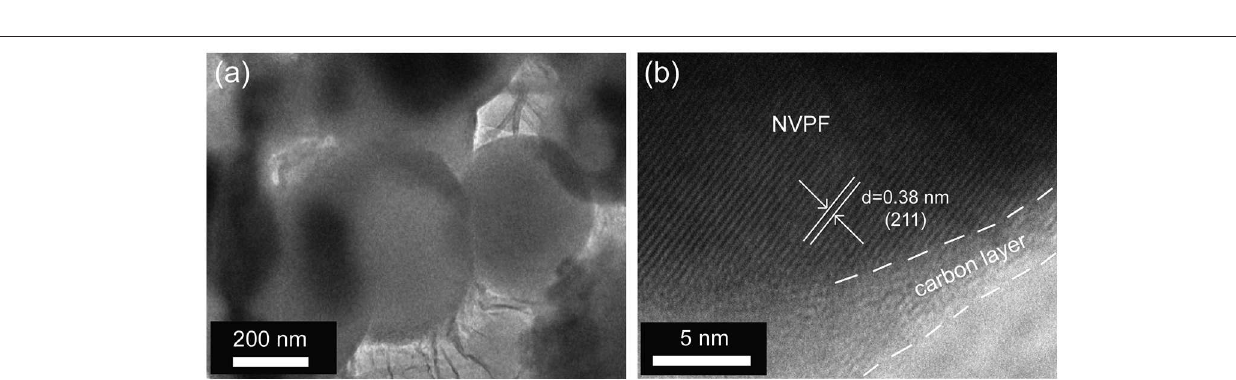
FIGURE 3 | (a,b) SEM images of NVPF/C/rGO under different magnifications; (c) the schematic illustration of NVPF/C/rGO; (d) the EDS mapping of NVPF/C/rGO.